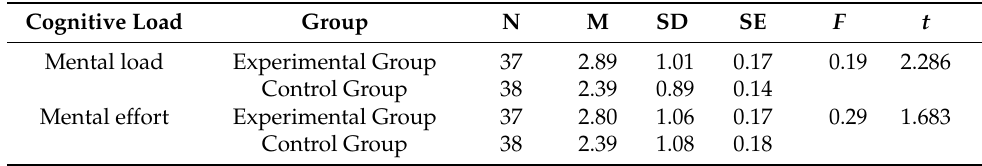
Table 6. The independent t -test analysis of cognitive load. Cognitive Load Group N M SD SE F t Mental load Experimental Group 37 Control Group Mental effort Experimental